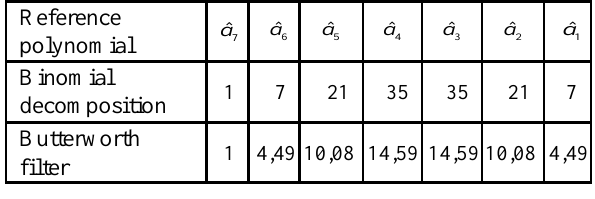
Table 5. Parameters of the synthesized drive of the test